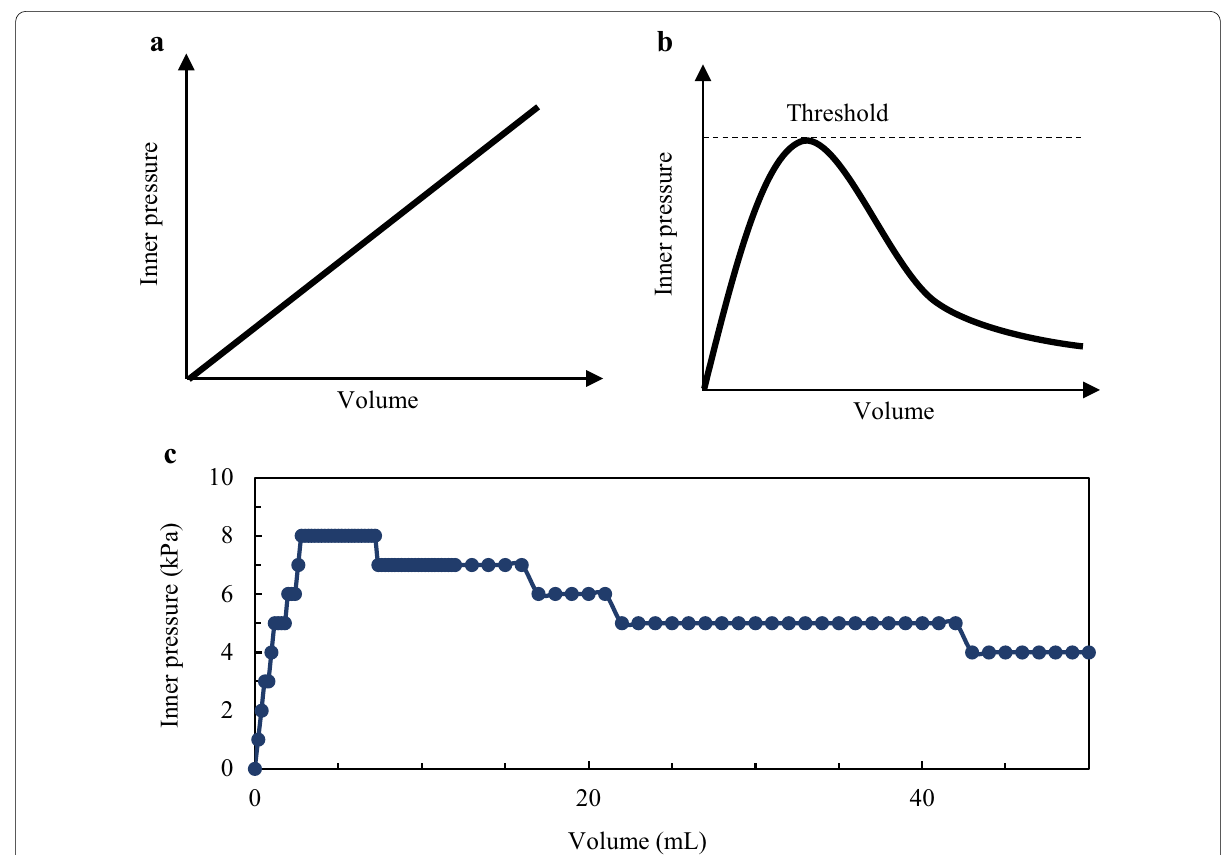
Fig. 3 PV diagrams of a balloon. a Linear PV diagram. b Nonlinear PV diagram with a peak. c PV diagrams of a latex balloon employed in this